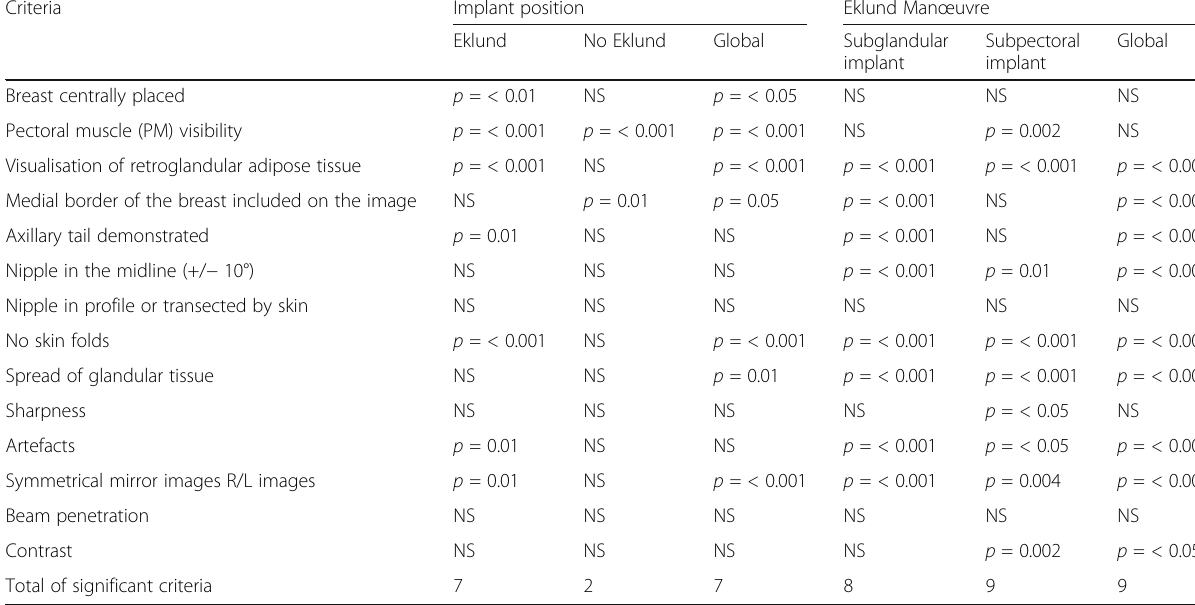
Table 4 Impact of implant position and Eklund Man œ uvre on the achievement of image quality criteria ( p , p value; NS , not